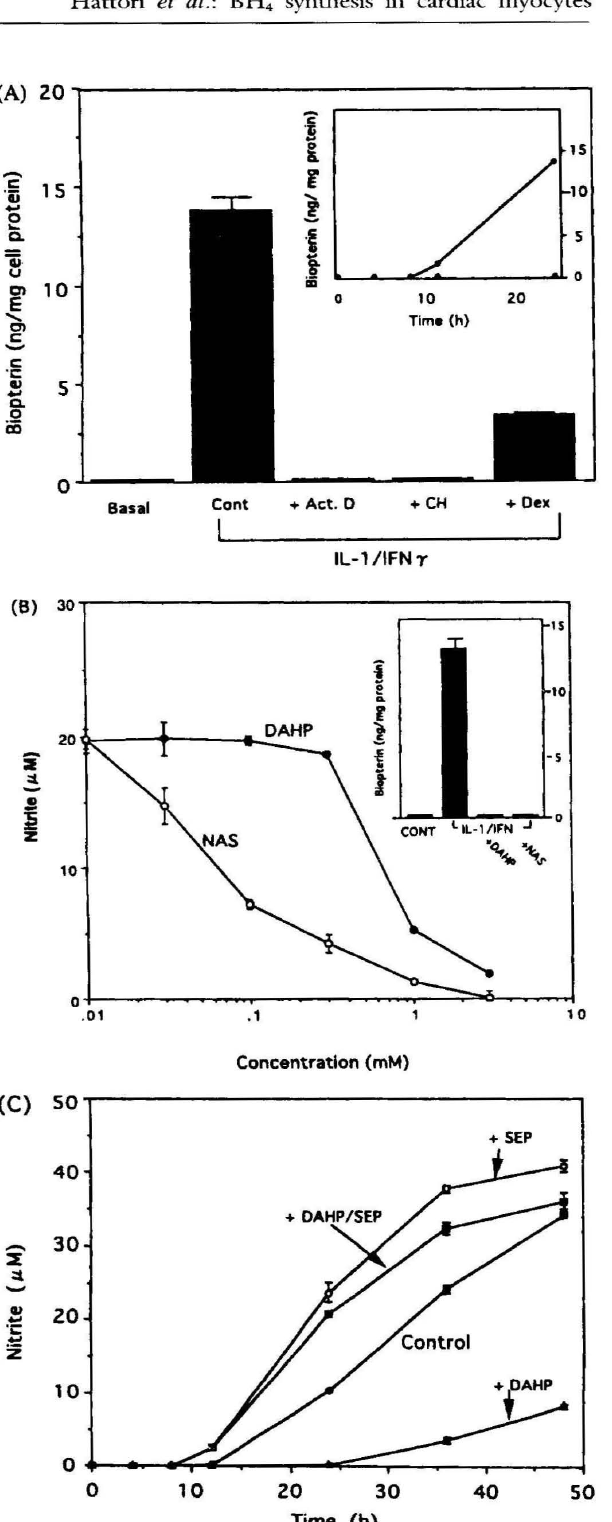
Figure 2. Influence of treaOTIent of cardiac myocytes with IL-l/IFN on total biopterin content of the cells (A) and effects of modulators of biopterin synthesis on IL-ljIFN activated nitrite synthesis in cardiac myocytes (B: 24-h in cubation, C: time course). Each point and bar represents the mean of four